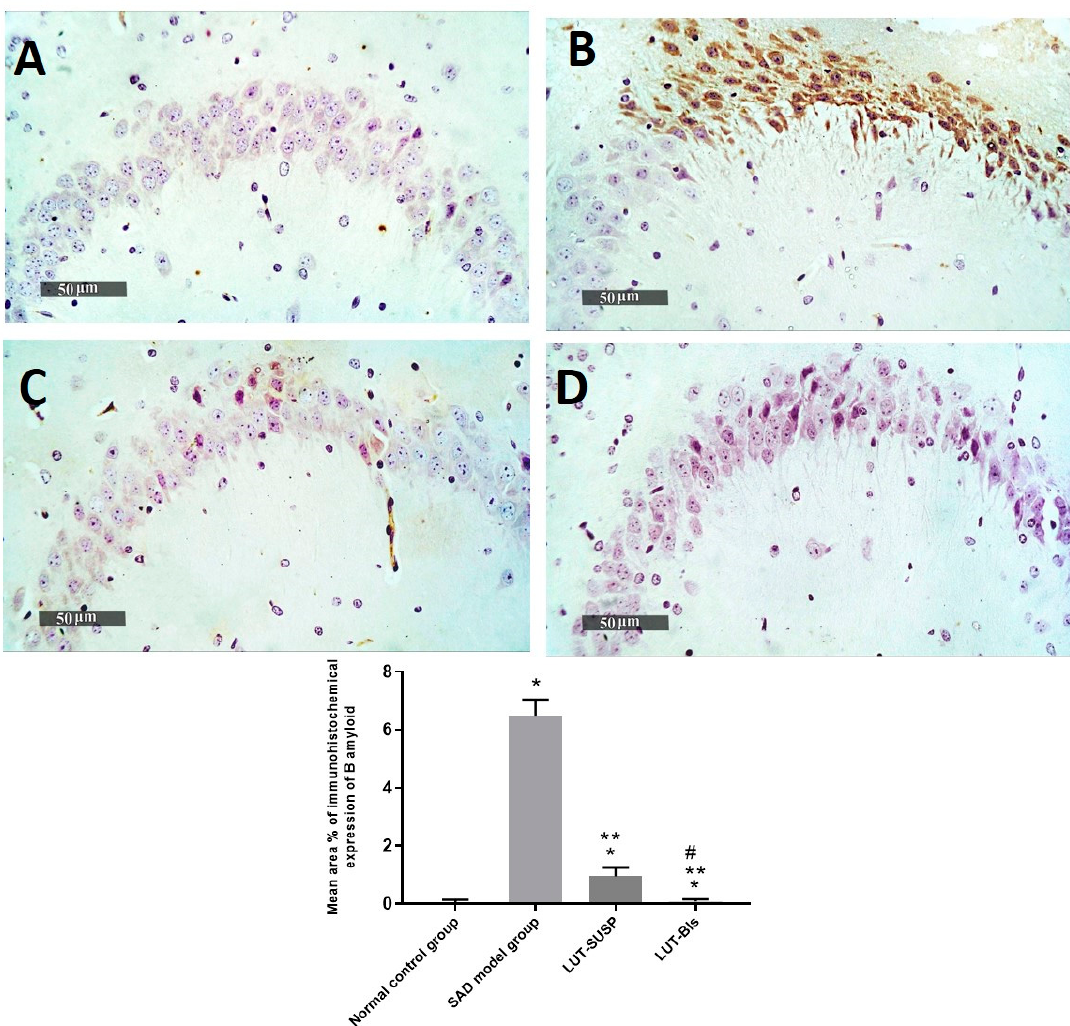
Figure 13. Ameliorative effect of different treatments on hippocampal intraneuronal beta amyloid immunohistochemical levels in pyramidal neurons. ( A ) Normal controls, ( B ) AD model samples, ( C ) LUT suspension samples, and ( D ) LUT-BL samples. Results were expressed as mean ± SD. * Statistically significant difference from normal control group, ** statistically significant difference from the SAD model group, and # statistically significant difference from LUT suspension group.